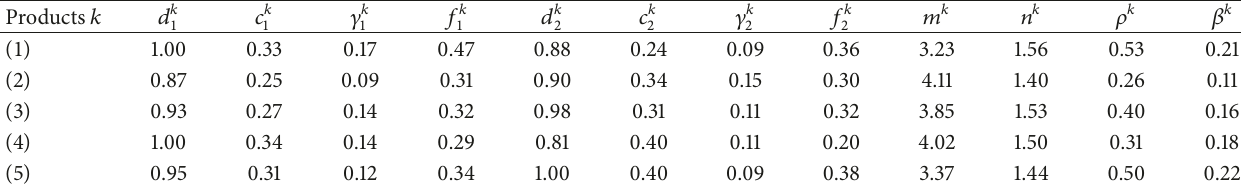
Table 2: Parameters setting in the